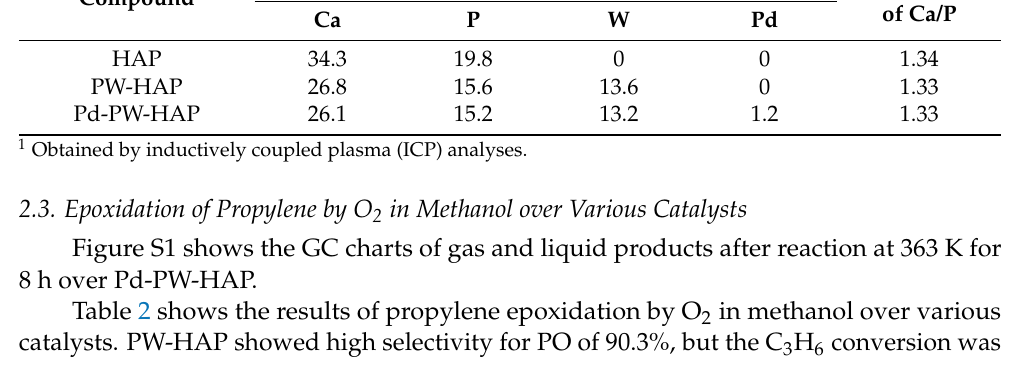
Table 1. Results of elemental analyses of various HAP-containing samples 1 .